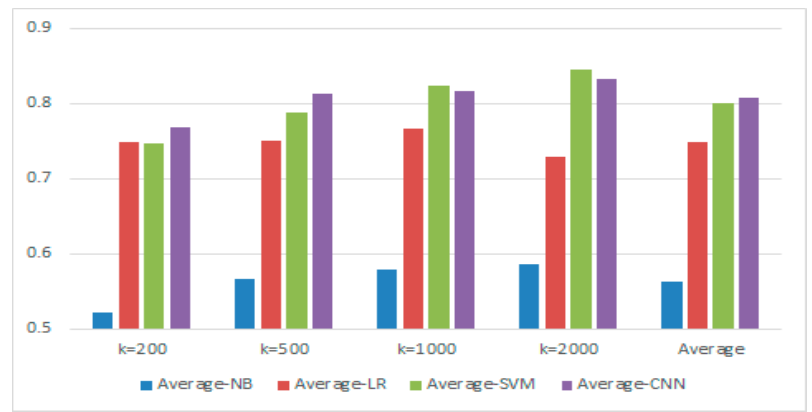
Figure 3. Accuracy results obtained by adding different numbers of target domain samples.